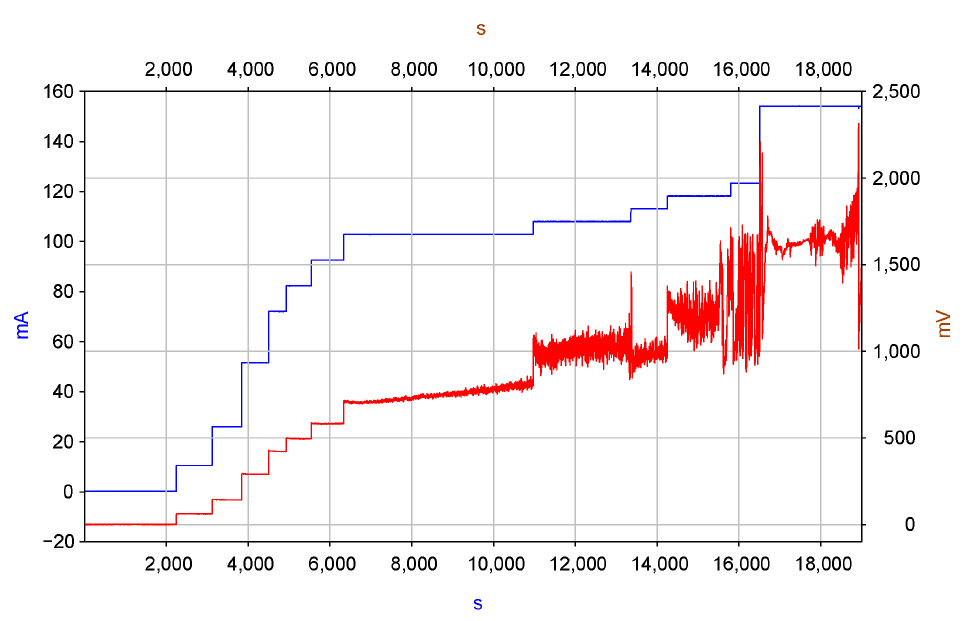
Figure 7. Changes in the current through the MHD cell (blue curve) and the voltage between the electrodes of the MHD cell (red curve).